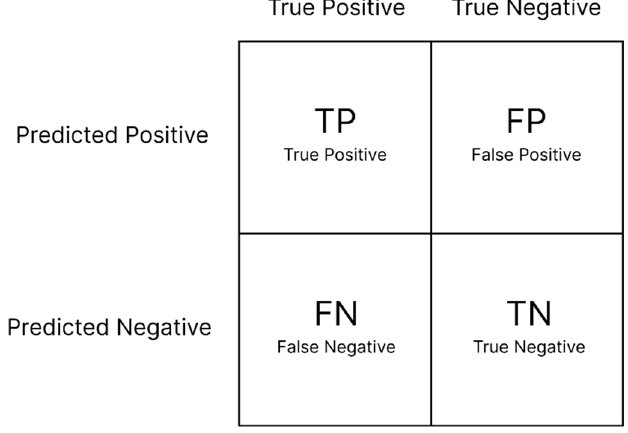
Figure 7. Basic concept of confusion matrixes for interpreting model classification results.